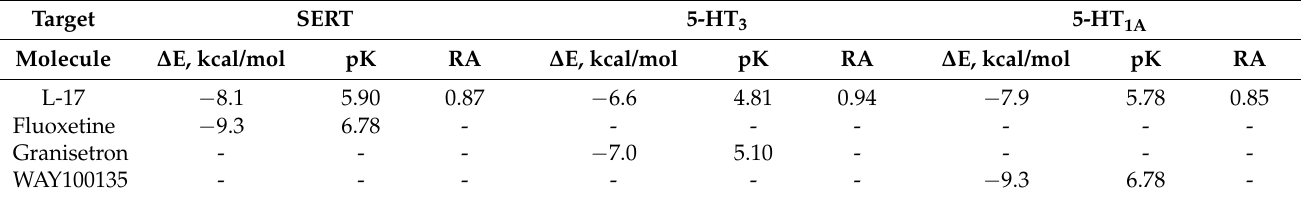
Table 1. Docking energy ( ∆ E), binding affinity (pK), and relevant affinity (RA) of L-17 to the SERT and 5-HT 3 /5-HT 1A receptors, compared to the SSRIs fluoxetine, granisetron, and WAY100135.